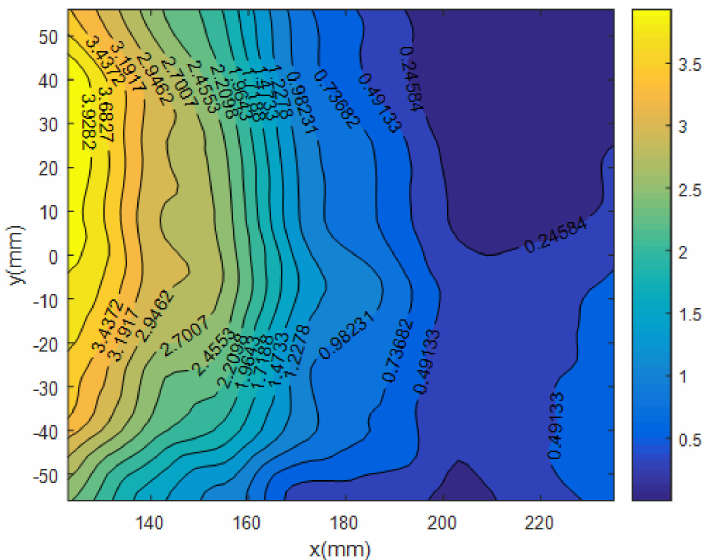
Figure 12. Absolute error distribution between the reconstructed WAI and the ground-truth